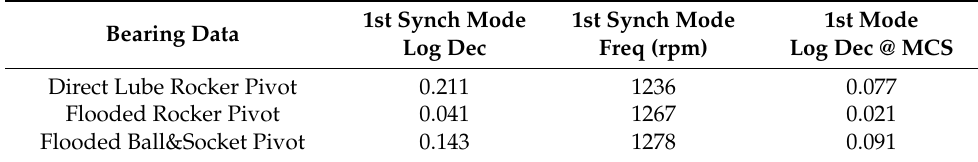
Table 6. Rotordynamics Comparison—1st Mode.